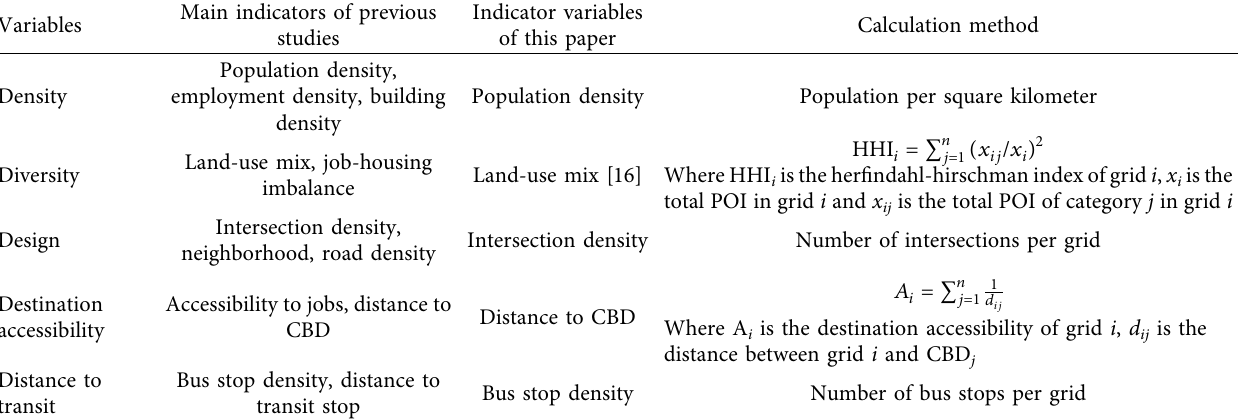
Table 1: Main indicators of the 5Ds.